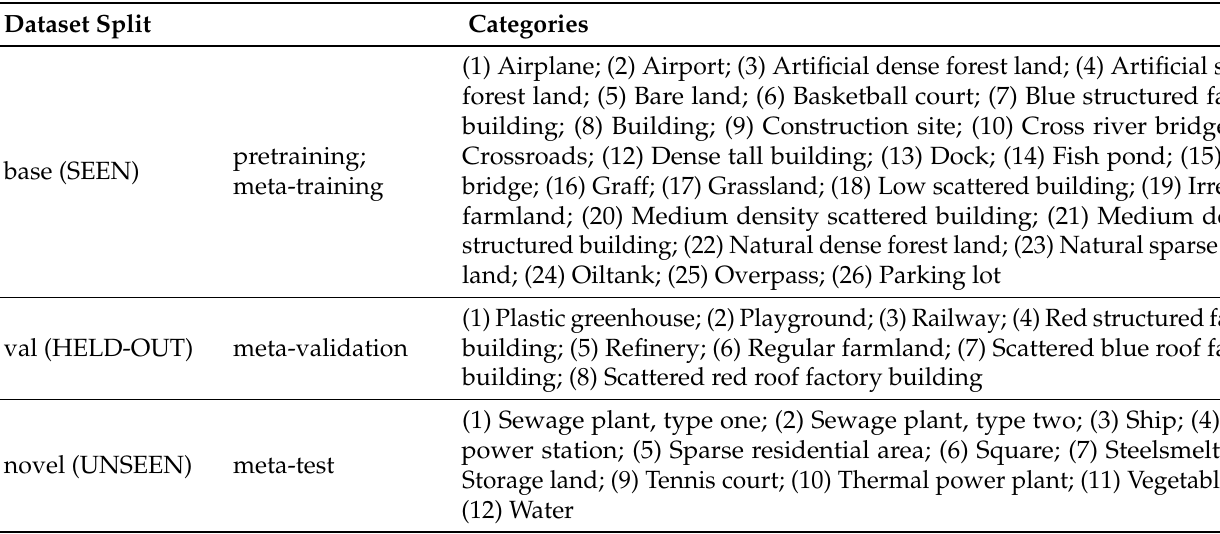
Table 2. RSD46-WHU dataset